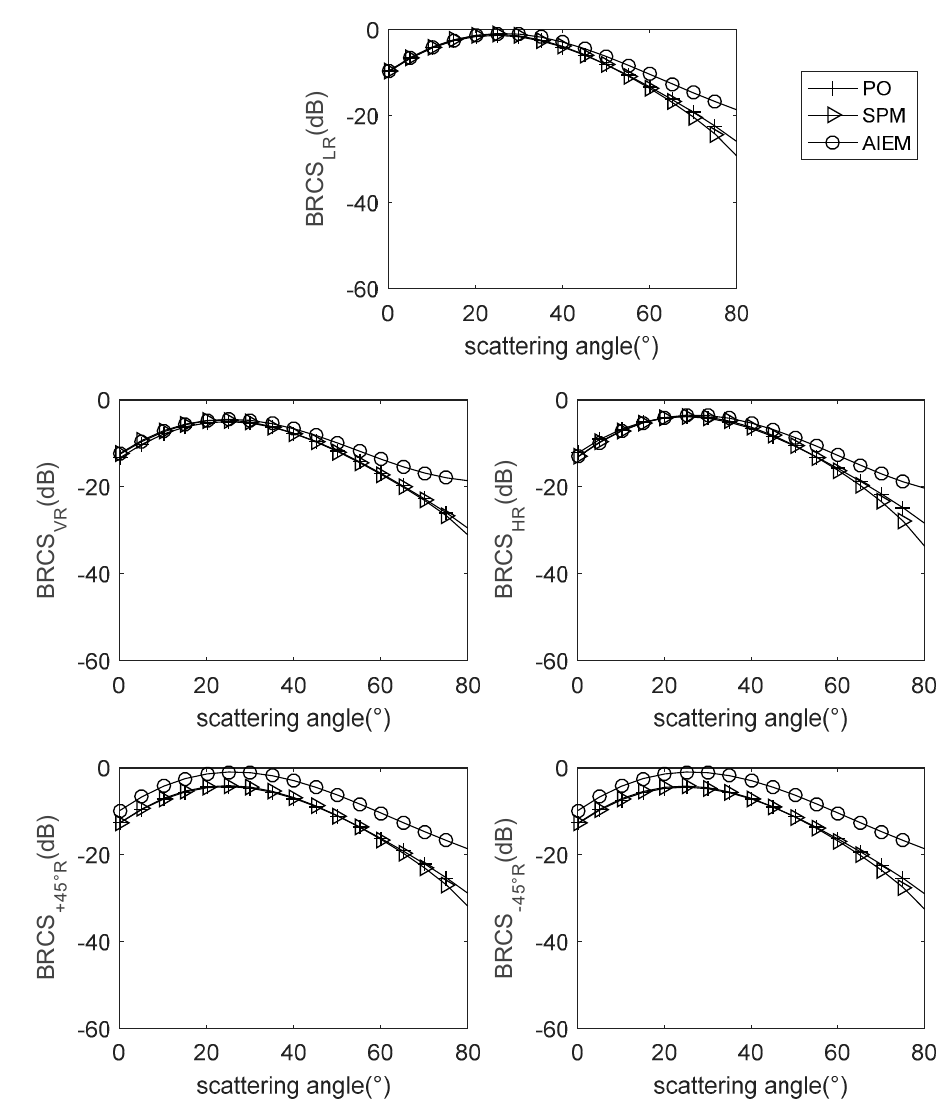
Figure 6. Scattering zenith angles’ e ff ects on BRCS at five di ff erent polarizations. θ i = 30 ◦ , ϕ s = 0 ◦ . Subfigures a to e represent the polarizations of LR, VR, HR, + 45 ◦ R and − 45 ◦ R, res pectively.